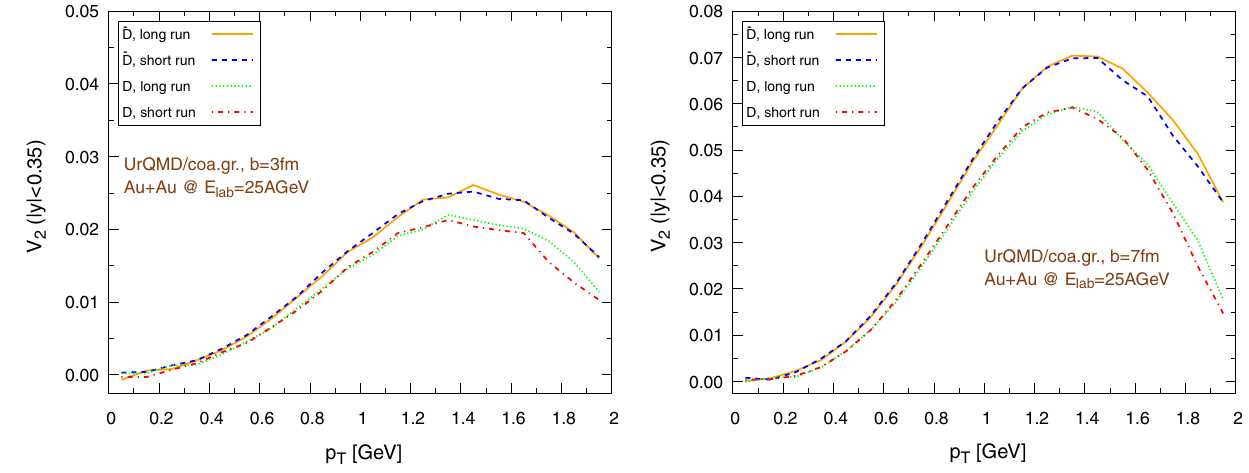
Fig. 22 Au+Au collisions at E lab = 25AGeV in the UrQMD/hybrid model. The hadronization parameters are (cid:23) p = 0 . 05 and 0 . 6fm. Left: b = 3fm, right: b = 7fm. Comparison between the ellip-